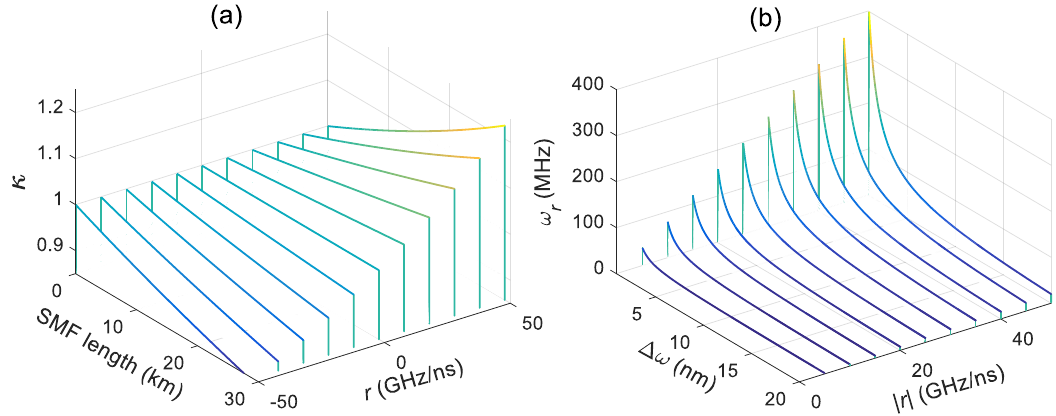
Figure 4. ( a ) The trend of κ as L and r changed; ( b ) the trend of ω r as Δ ω and r changed.